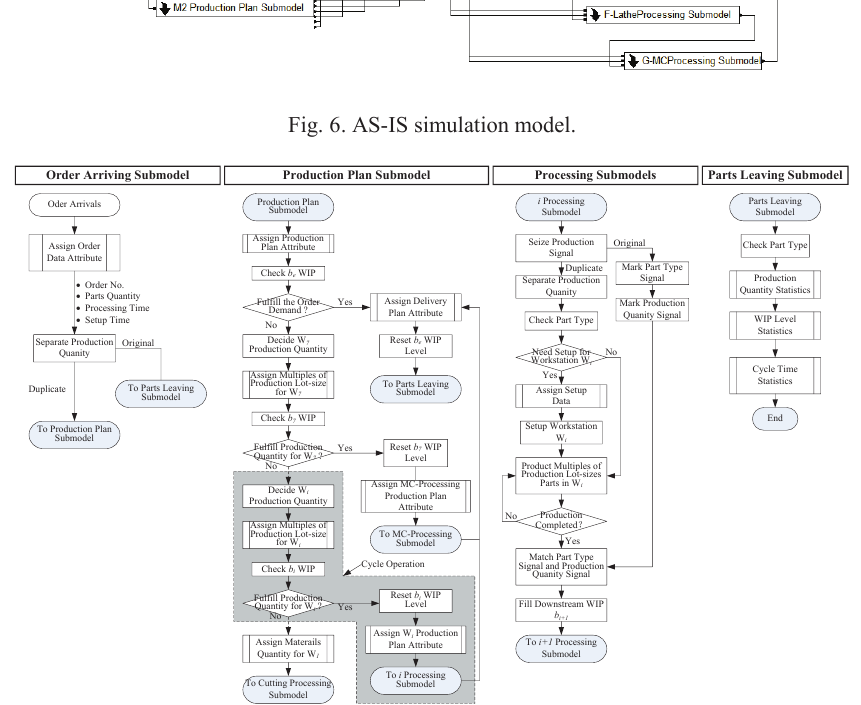
Fig. 7. The main simulation logic of the AS-IS model based on back